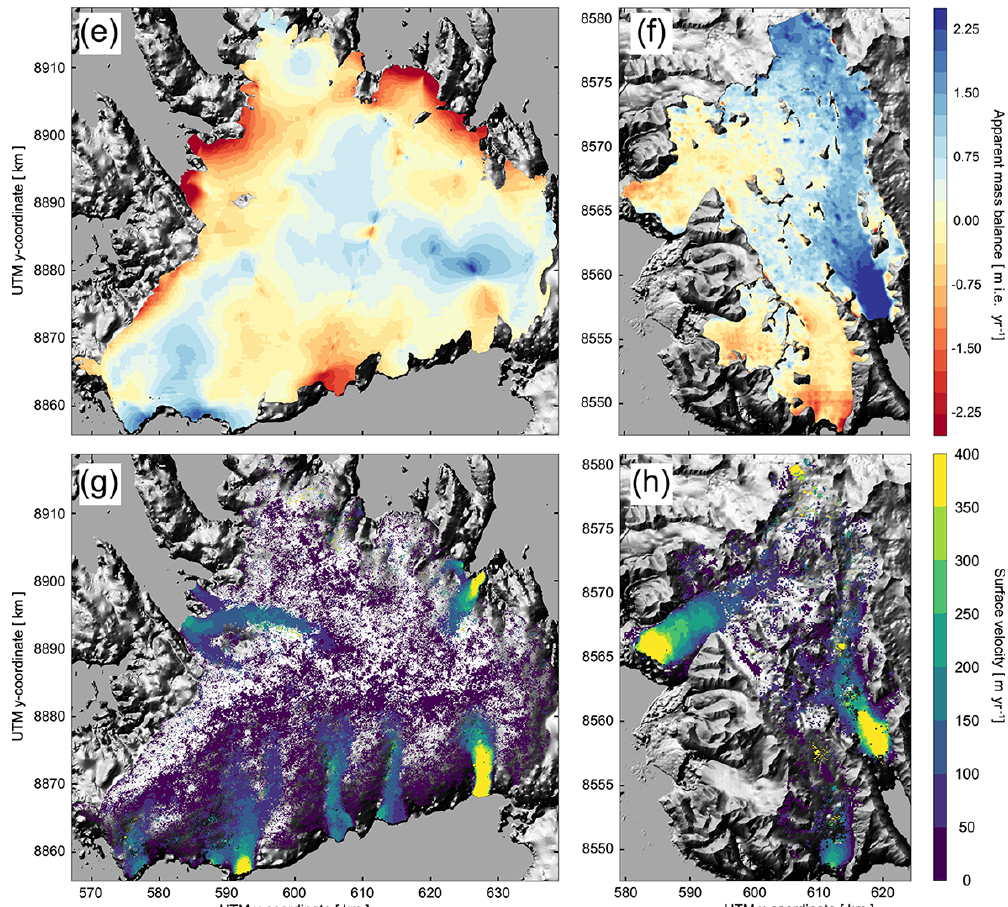
Figure 2. Input fields to the ice-thickness reconstruction for VIC (a, c, e, g) , THPB and WSB (b, d, f, h) . Surface mass balance (SMB) input (a, b) is provided by MAR as an average over the period 1979–2014 (Lang et al., 2015). Elevation changes on VIC (c) are inferred from 2003–2007 ICESat profiles. The line information along the ICESat track was linearly interpolated. In southern Spitsbergen, elevation changes (d) were inferred from DEM differencing. A 2008 SPOT-HRS DEM was referenced to the 1990 DEM from the Norwegian Polar Institute (NPI, http://publicdatasets.data.npolar.no/kartdata/NP_S0_DTM20.zip). The difference between SMB and surface elevation changes (e, f) is referred to as the AMB. Surface velocity magnitudes (g, h) were inferred from 2015–2016 Sentinel-1 imagery. Background: grey-scale hill-shaded topography based on a NPI 50m DEM